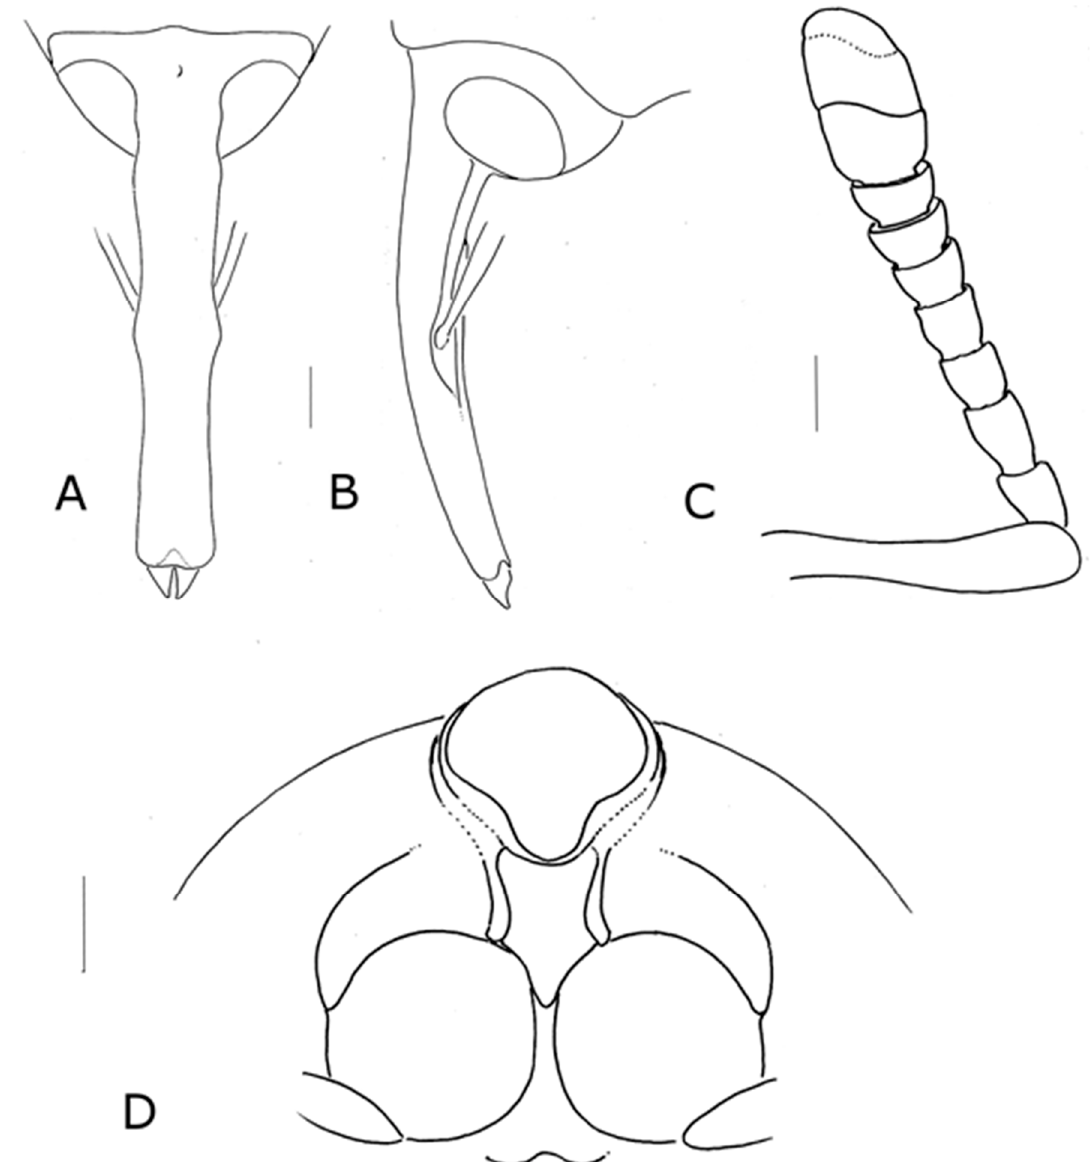
Figure 2. Sclerocardius bohemani Schoenherr: ( A ) head dorsal (scale bar = 0.5 mm), ( B ) head lateral (scale bar = 0.5 mm), ( C ) antenna dorsal (scale bar = 0.5 mm), and ( D ) prothorax, ventral (scale bar = 1 mm).